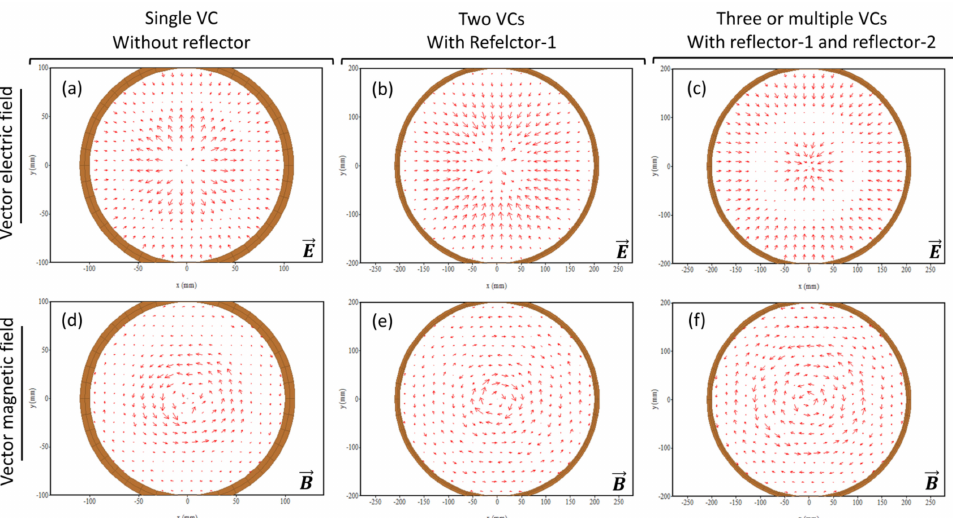
Figure 6. The vector field profiles were obtained at the waveguide end by using 3D PICSC. The ( a – c ) shows the VEF and ( d – f ) shows the VMF profiles with a single VC, two VCs, and three or multi- ple VCs, without reflectors, with one reflector, and with two reflectors, respectively. The dominant mode was found to be TM 01 and remained almost unchanged with multiple VCs’